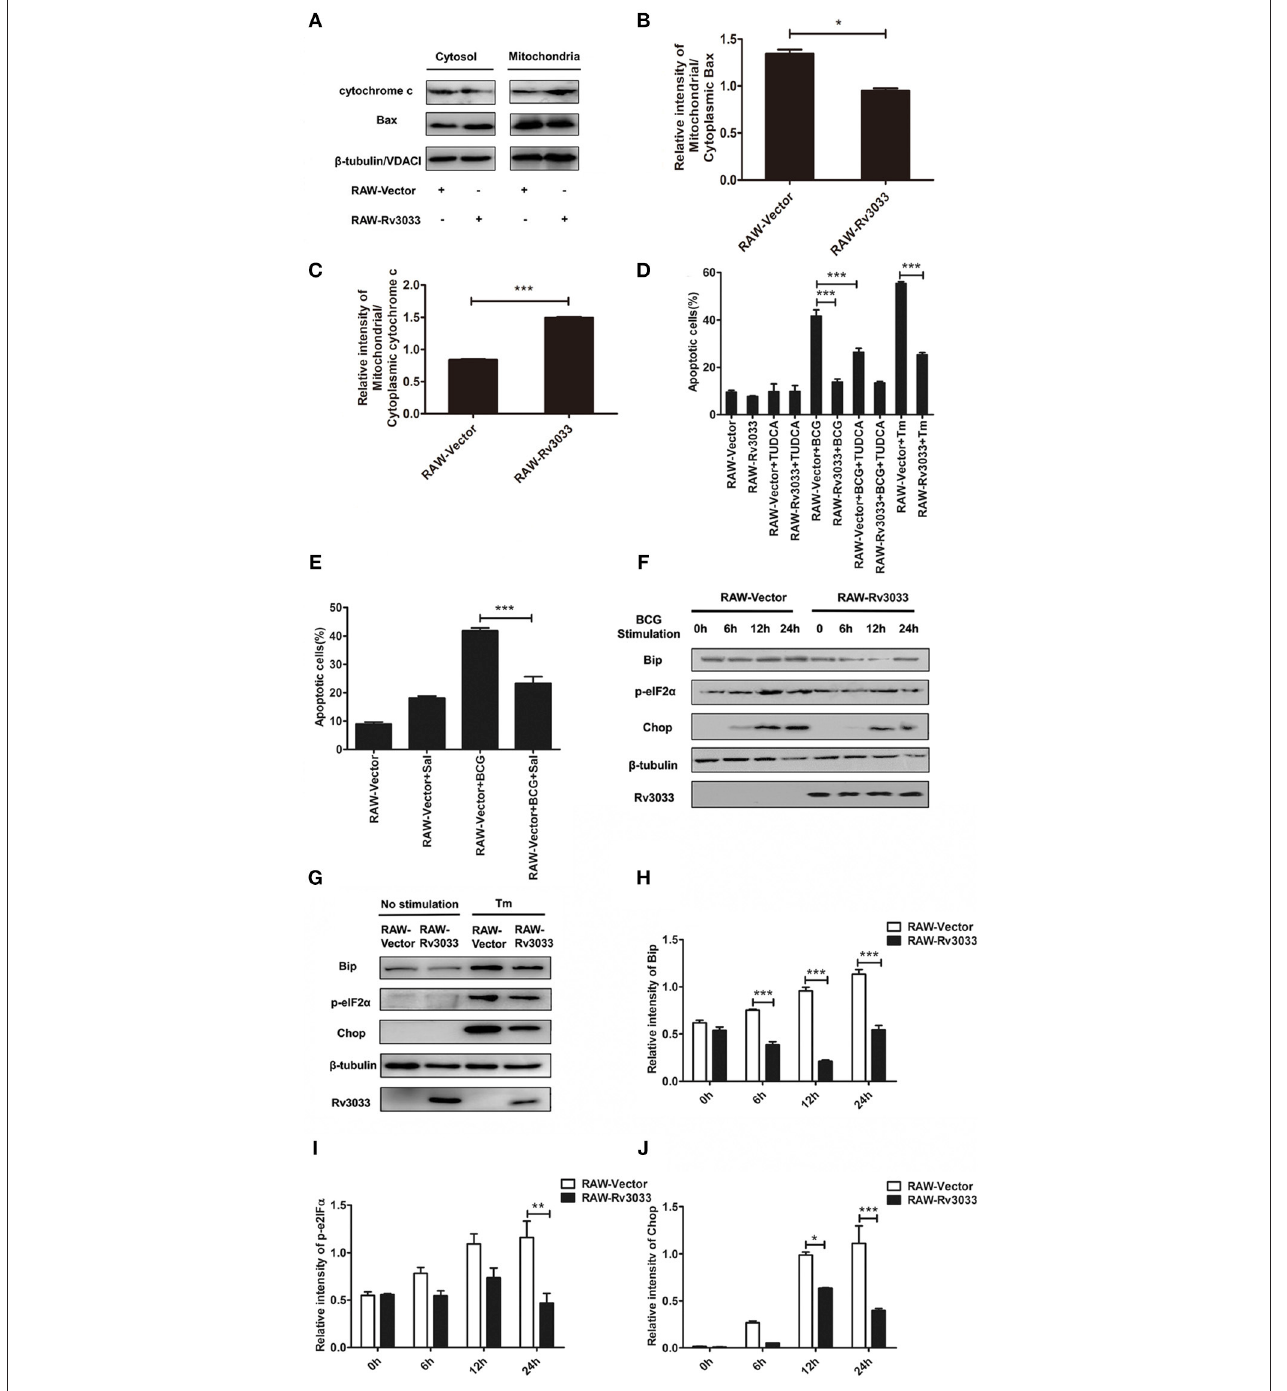
FIGURE 5 | Rv3033 inhibition on intrinsic apoptosis were mediated by blocking the mitochondrial as well as ER stress PERK branch pathways. (A) RAW-Vector and RAW-Rv3033 cells were infected with BCG (MOI = 10) for 24h. Mitochondrial fractions were isolated from whole cell lysates in RAW264.7 cells. The protein levels of Bax and cytochrome c were detected by western blot of the supernatant and mitochondrial fractions. (B,C) Semi-quantification of Bax and cytochrome c. (D) RAW-Vector and RAW-Rv3033 cells were infected with BCG (MOI = 10) pretreated with or without TUDCA (500 µ g/ml) for 36h. Apoptotic cells were determined by Annexin V/7-AAD staining assays. (E) RAW-Vector and RAW-Rv3033 cells were infected with BCG (MOI = 10) pretreated with or without salubrinal (10 µ M) for 36h. Apoptotic cells were determined by Annexin V/7-AAD staining assays. (F) RAW-Vector and RAW-Rv3033 cells were infected with BCG (MOI = 10) for 6, 12, or 24h. Bip, p-eIF2 α and chop were determined by western blot analyses. (G) RAW-Vector and RAW-Rv3033 cells were stimulated with Tm (5 µ g/ml) for 12h, and Bip, p-eIF2 α and Chop were determined by western blot analyses. (H–J) Semi-quantification of Bip, p-eIF2 α , and Chop. Data are performed as the mean ( ± SEM) and from one representative experiment of three independent experiments. (* p < 0.05; ** p < 0.01; *** p < 0.001).